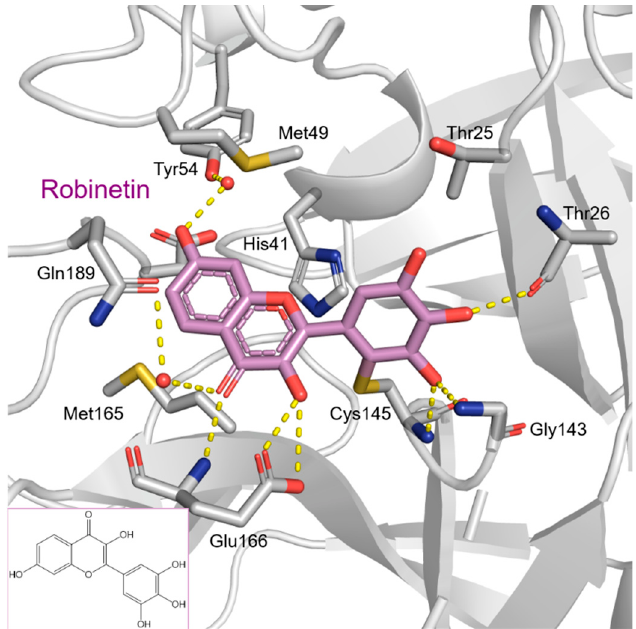
Figure 2. The covalent-binding mode of robinetin in the M pro ligand-binding site revealed by X-ray crystal structure (PDB code: 8HI9). Dashed yellow lines represent polar interactions (hydrogen bonds and water